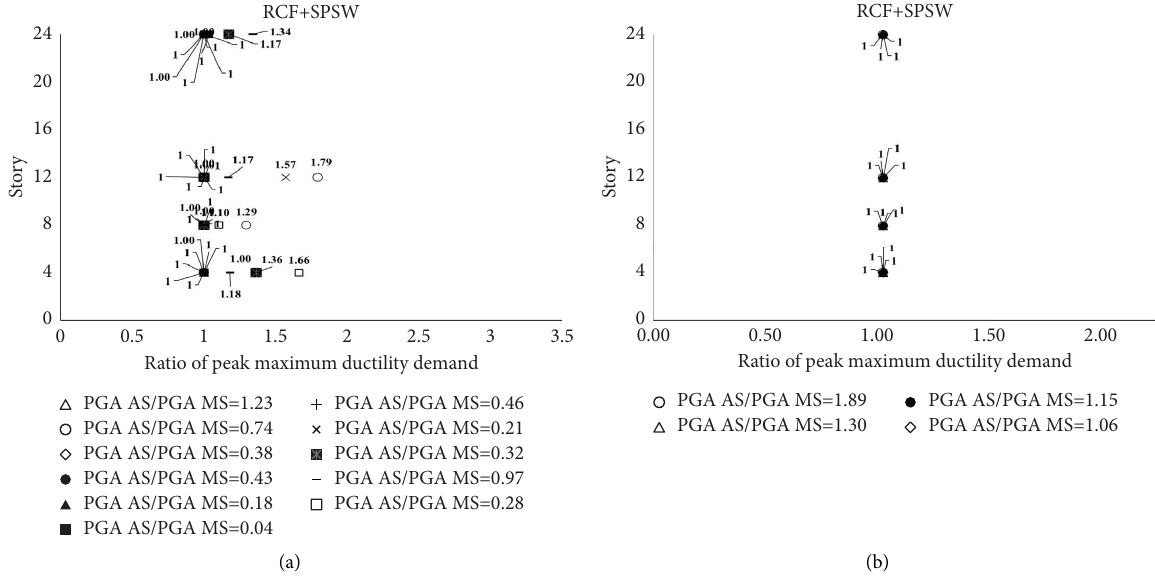
Figure 16: Ratio of peak maximum ductility demand of RCF with SPSW in SS to MS: (a) combination of group I and II, (b) group